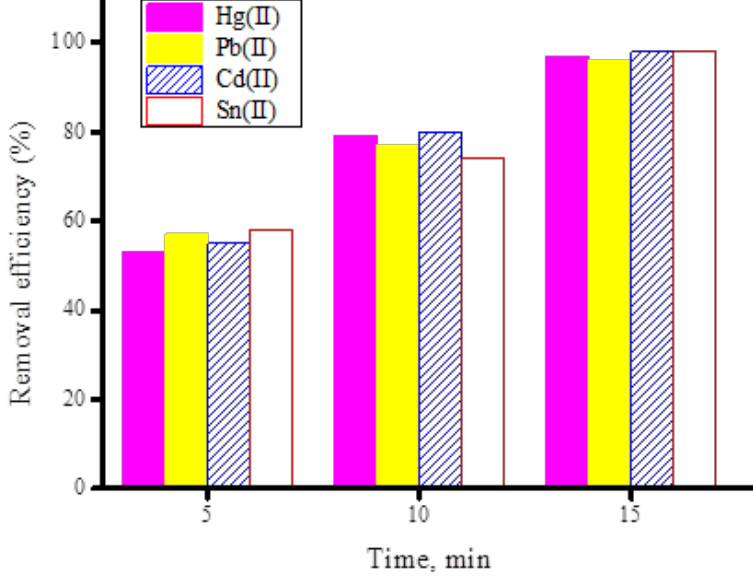
Figure 12. Removal efficiency (%) of heavy metal ions (20 mg/100 mL) using 50 mg of the synthesized ZnFe 2 O 4 -CNT adsorbent material at different contact times.